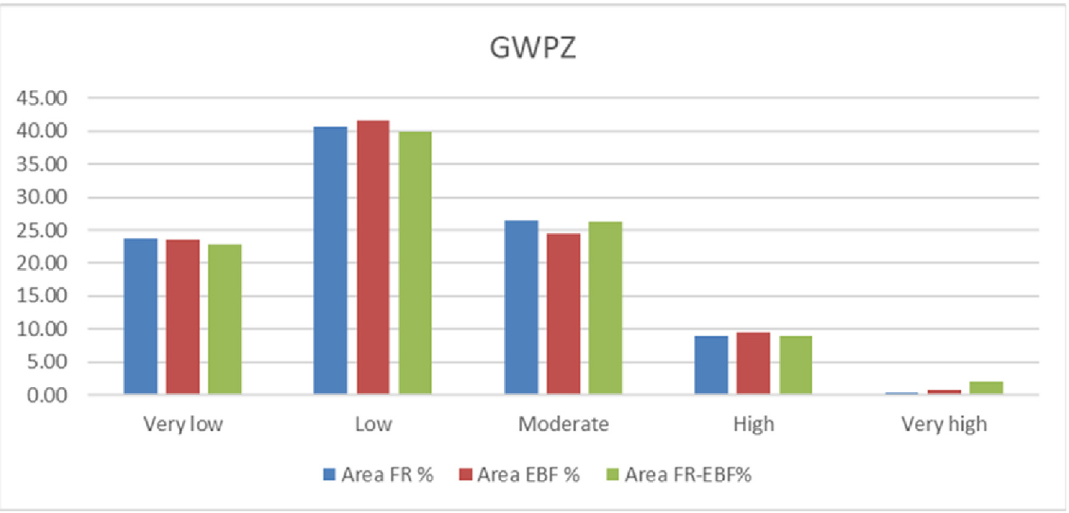
Figure 8. GWPZ areas of three models.